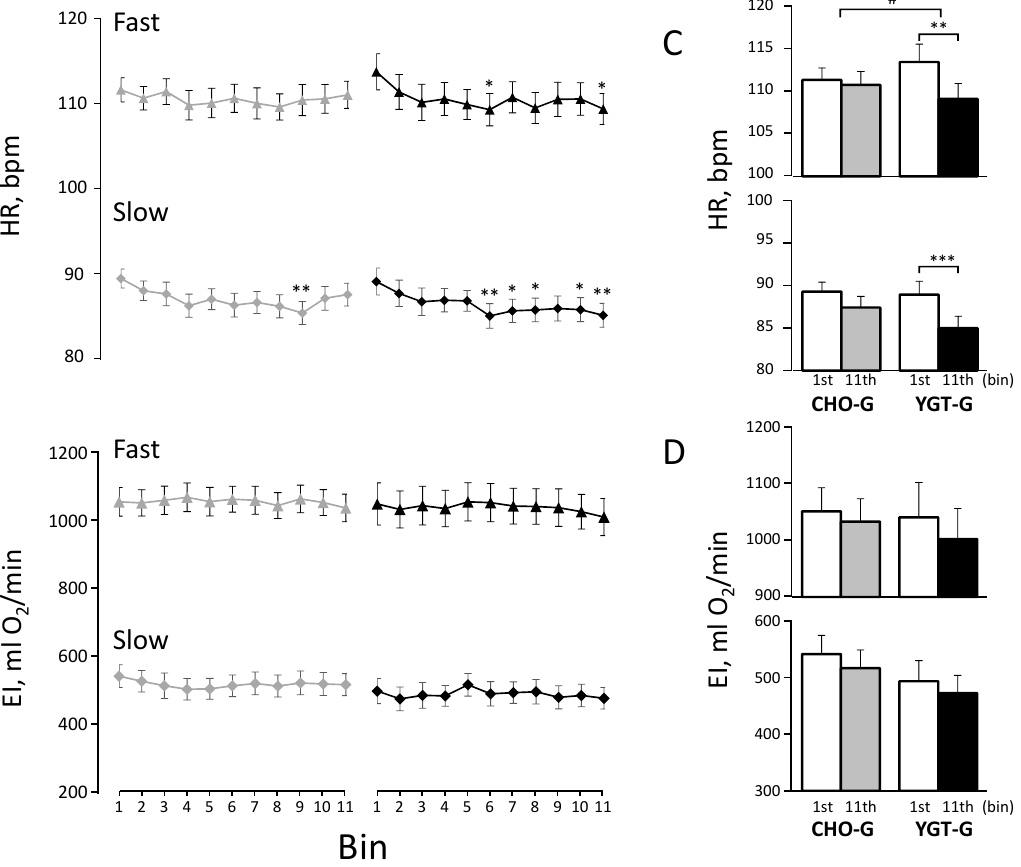
Figure 3. The profiles of heart rate (HR) ( A ) and exercise intensity (EI) ( B ) for the first set of IWT throughout the intervention in both groups. The gray lines and symbols indicate the values in the carbohydrate intake group (CHO-G), and the black lines and symbols indicate those in the yogurt intake group (YGT-G). The comparison of HR fast and HR slow between the 1st and 11th bins are presented in the upper and lower panels, respectively ( C ). Similarly, the comparison of EI fast and EI slow between the 1st and 11th bins are presented in the upper and lower panels, respectively ( D ). The open columns indicate HR or EI in the 1st bin for both groups, and the gray and the black columns indicate HR or EI in the 11th bin for CHO-G and YGT-G, respectively. Values are presented as means ± SE bars for 39 subjects in CHO-G and for 37 subjects in YGT-G. *, **, and *** indicate significant differences vs. the 1st bin at the levels of p < 0.05, p < 0.01, and p < 0.001, respectively. # indicates significant interactive effect, bins (the 1st vs. the 11th bins) x groups (CHO-G vs. YGT-G), at the level of p <